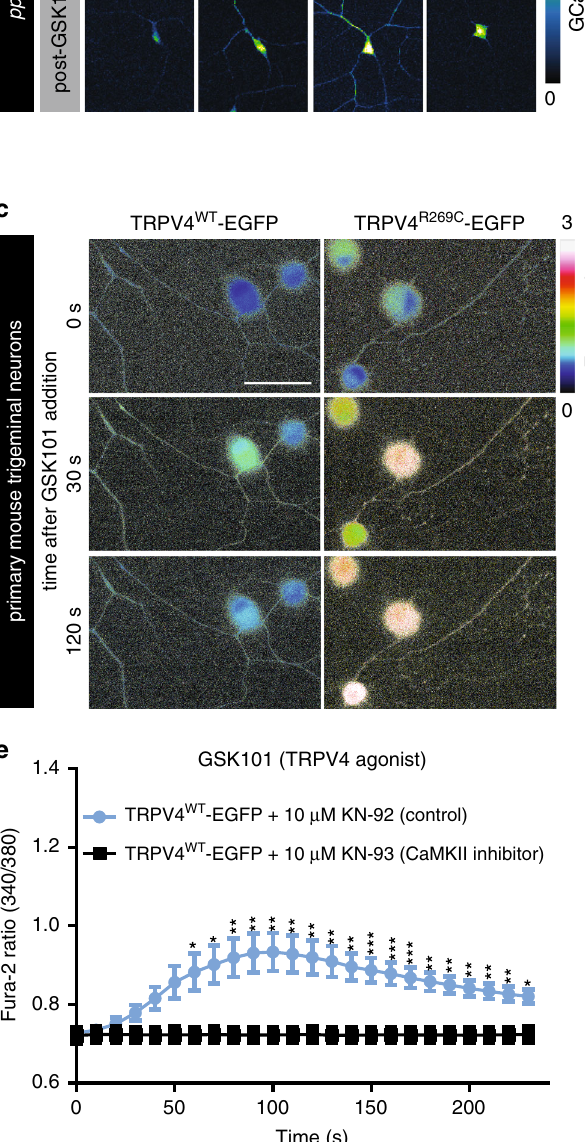
Like fl y neurons, mouse trigeminal neurons transduced with TRPV4 R269C -EGFP respond more rapidly and more robustly to GSK101 with a t 1/2 max of 16 ± 3.8 s (best fi t parameter ± SEM) as compared with TRPV4 WT (28 ± 8.5 s) (Fig. 5c, d). The maximum response of TRPV4 R269C (1.2 ± 0.016) is greater than that of TRPV4 WT (0.91 ± 0.014) ( p < 0.0001). Collectively, these data indicate that the R269C mutation sensitizes the TRPV4 channel in Drosophila neurons in vivo and primary mammalian neurons